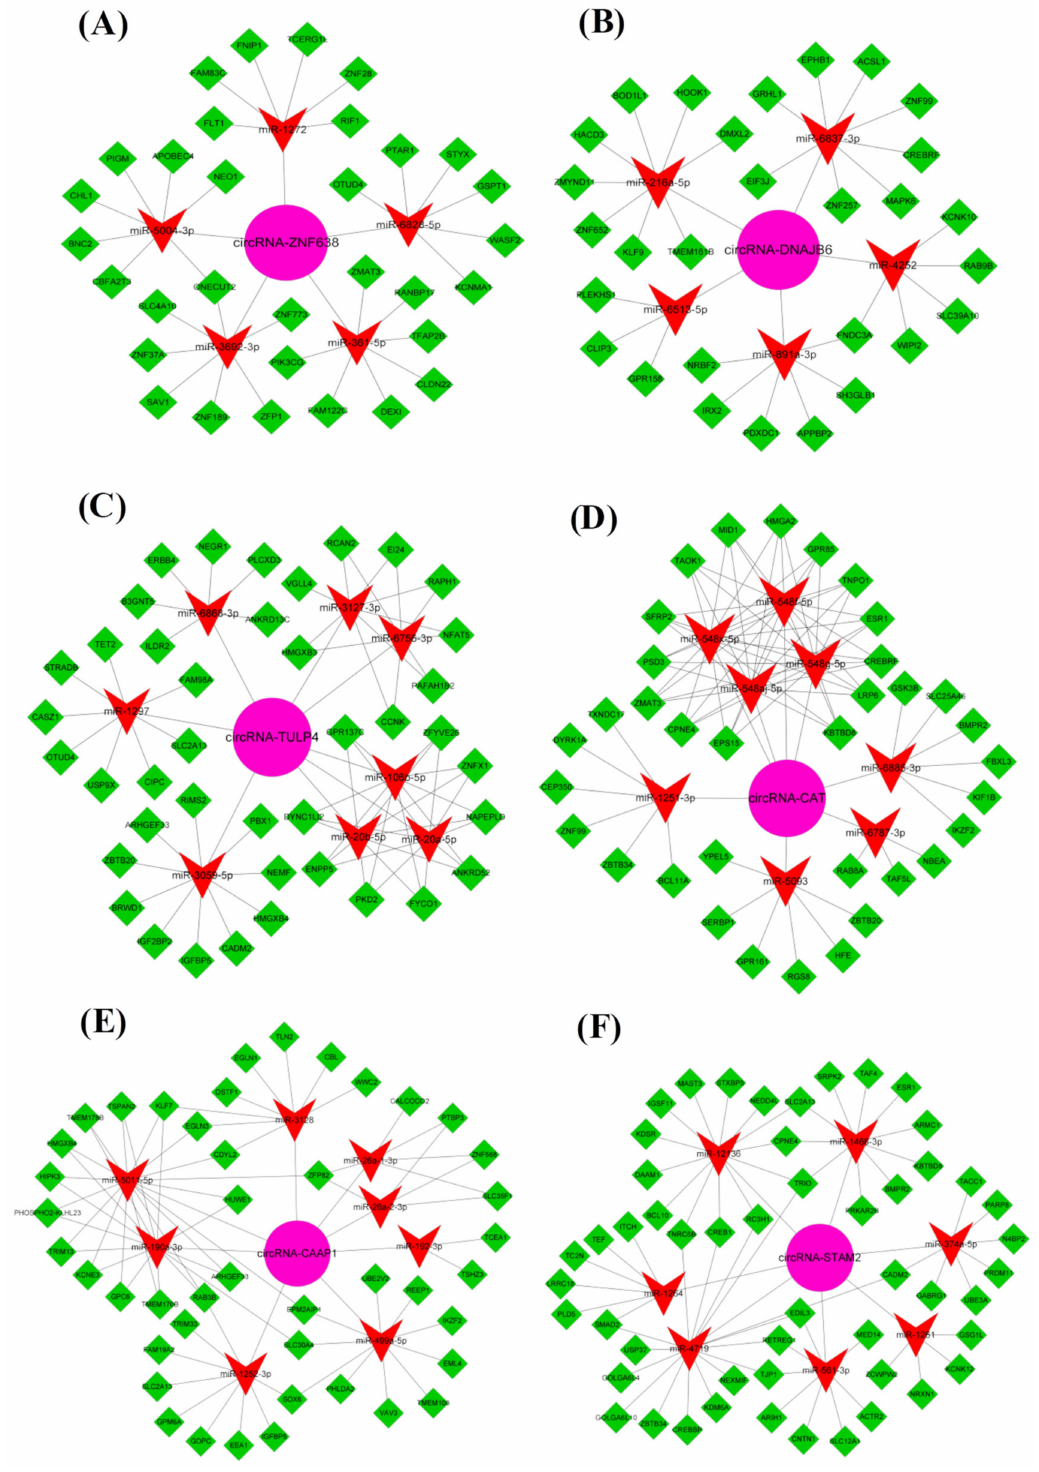
Figure 4. The ceRNA regulatory network of each putative m 6 A-circRNA with higher expression in anagen skin tissue of cashmere goats in comparison to telogen. The pink circle, red “V”, green diamond shapes represent m 6 A-circRNAs, miRNAs and target genes, respectively. ( A ) circRNA- ZNF638 = m 6 A-circRNA-ZNF638; ( B ) circRNA-DNAJB6 = m 6 A-circRNA-DNAJB6; ( C ) circRNA- TULP4 = m 6 A-circRNA-TULP4; ( D ) circRNA-CAT = m 6 A-circRNA-CAT; ( E ) circRNA-CAAP1 = m 6 A-circRNA-CAAP1; ( F ) circRNA-STAM2 = m 6